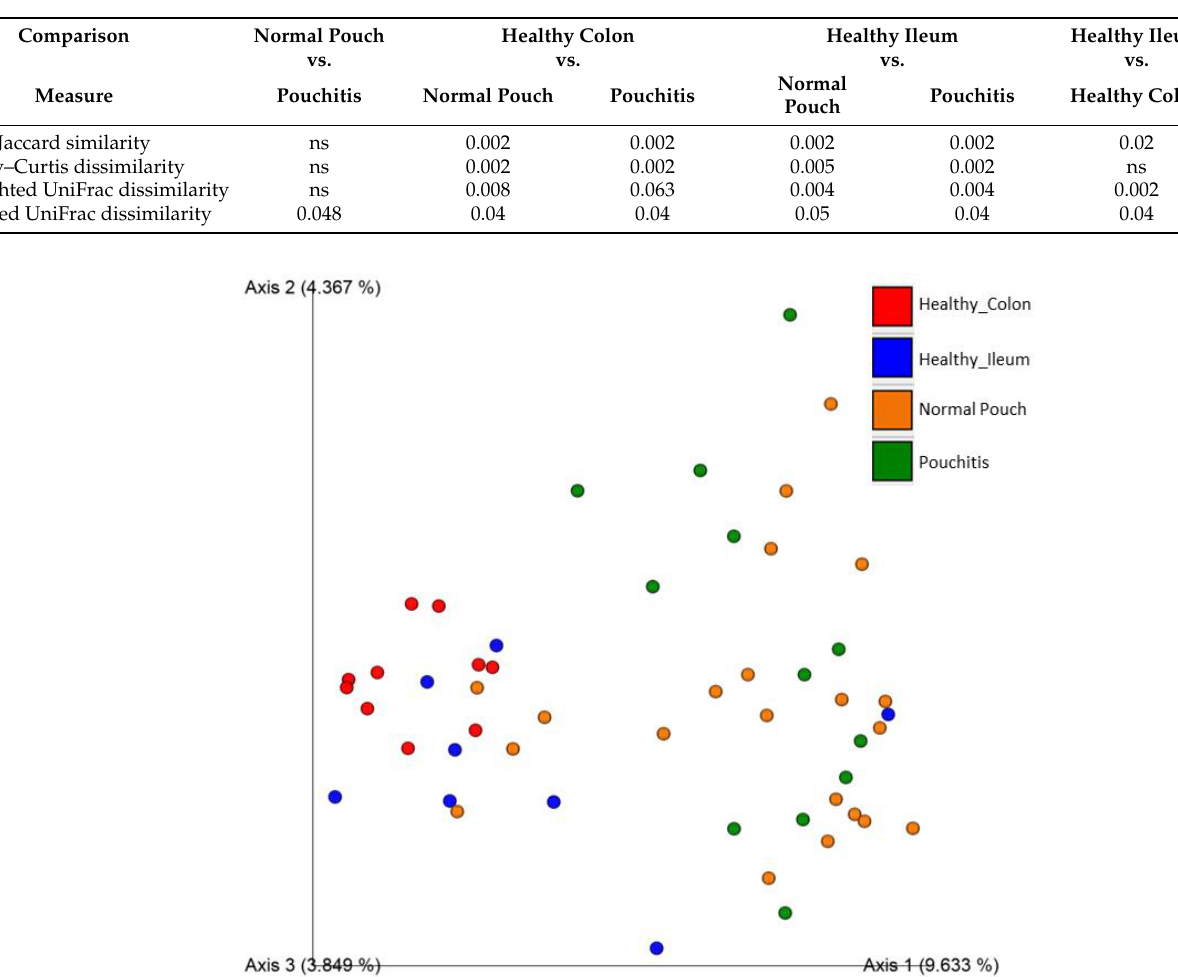
Table 3. Summary of pairwise group comparisons for beta diversity measures. Benjamini and Hochberg corrected p -values ( q -values) for PERMANOVA tests are shown; “ns”: q -value > 0.05.